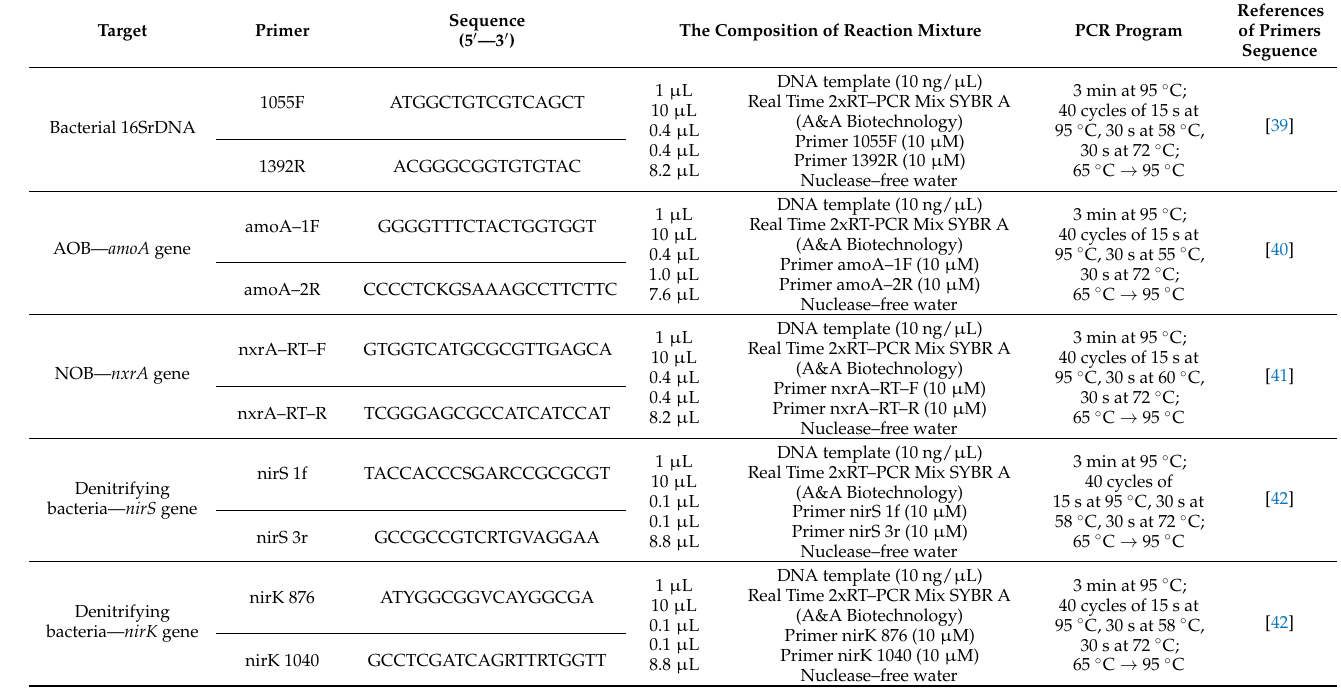
Table 3. Primers and PCR